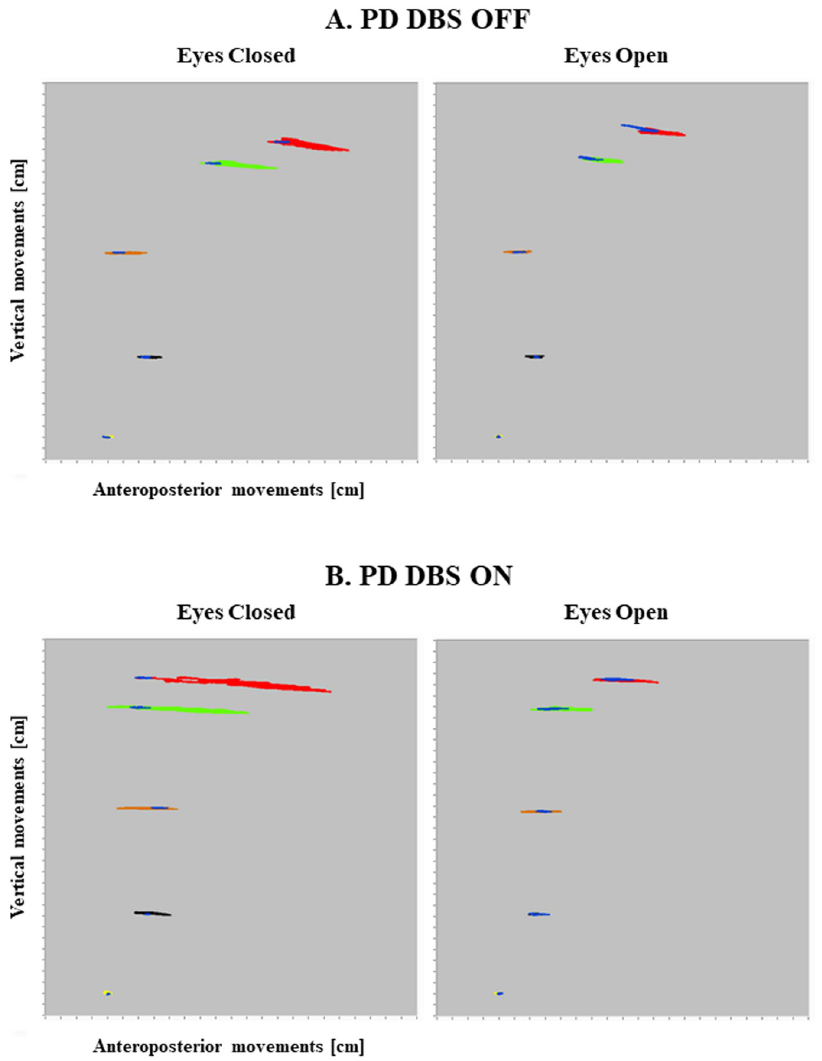
Fig 3. Body movement recordings from a PD subject during DBS OFF and DBS ON. The figure presents the body movements during Fig 3A: DBS OFF and Fig 3B: DBS ON. The red color marks the head movement; the green color the shoulder movement; the orange color the hip movement; the black color the knee movement and the yellow color the ankle movement. The blue segment at each marker position marks the movements made during quiet stance. The sizes of all body movements were reduced in DBS OFF as compared to with DBS ON. However, the posture was deformed with DBS OFF by increased leaning forward of the head, shoulder and knees and by a more backward position of the